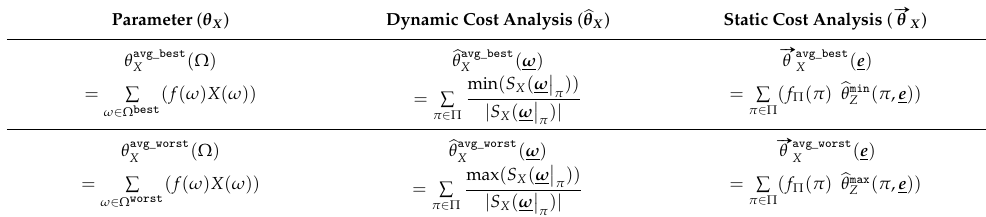
Table 3. An extension of Table 2 with two more